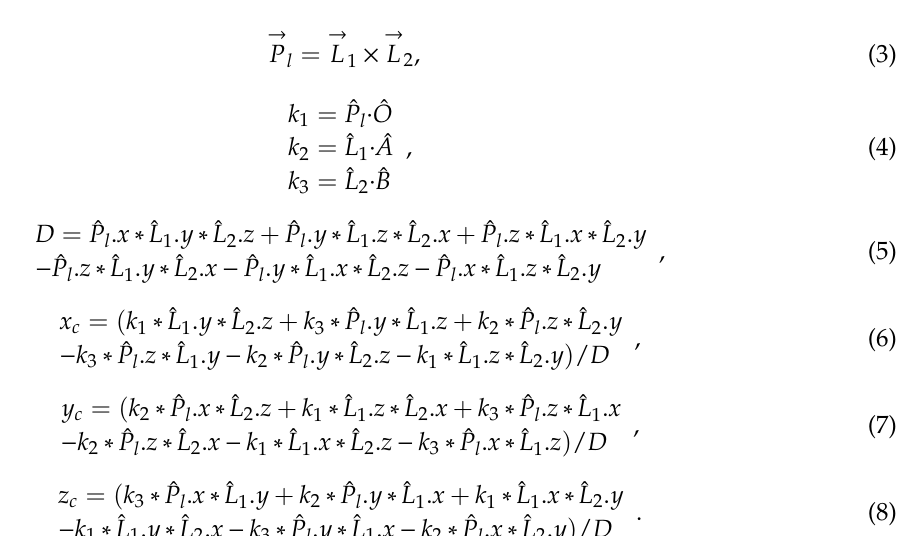
Figure 3. The result of the inflection point projected onto the plane.